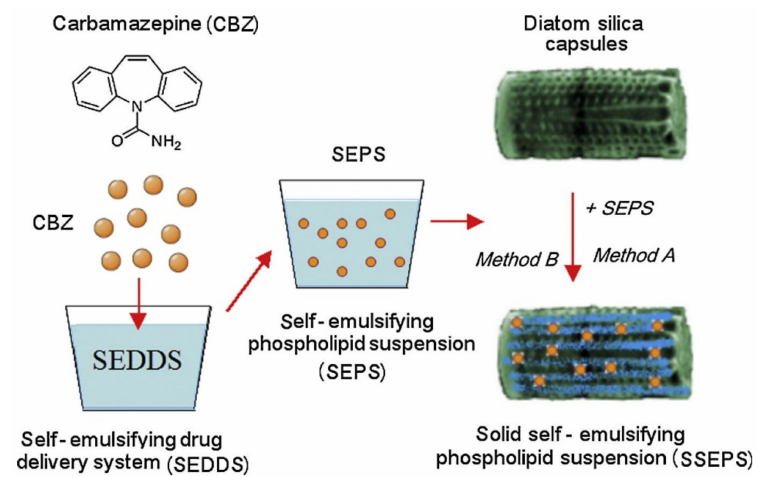
Figure 3. Schematic presentation of solid self-emulsifying phospholipid suspension (SSEPS) preparation. CBZ—carbamazepine; SEDDS—solid self-emulsifying drug delivery system; SEPS—self-emulsifying phospholipid suspension; diatoms—diatom silica particles. Reprinted from [58], copyright (2014), with permission from